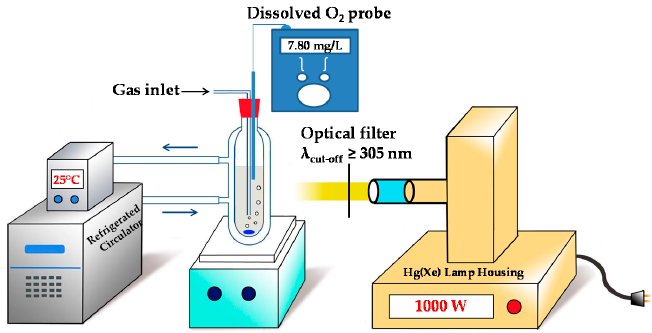
Figure 6. Diagram of the photochemical setup.